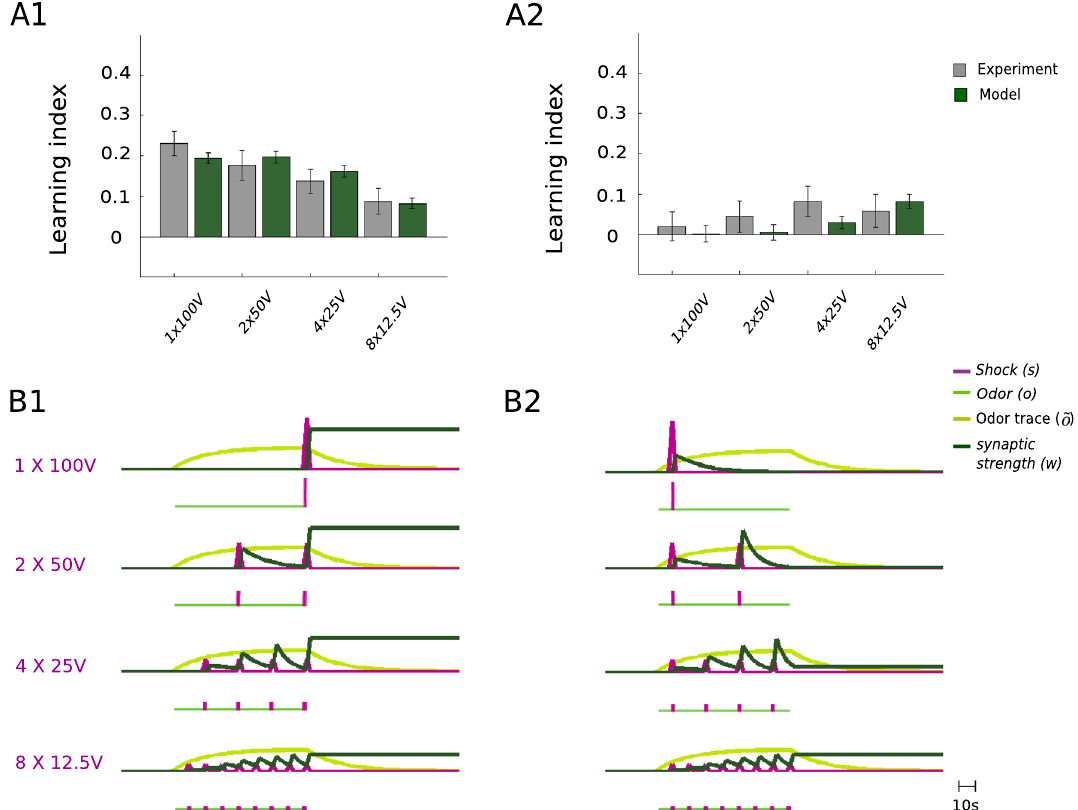
Figure 3. Predictive plasticity captures the sequence conditioning experiments. (A) In contrast to the purely associative learning (Eq. 6), the predictive plasticity (Eq. 7) fits well the shock-at-end data ( A1 ) and the shock-at-beginning data ( A2 , see Fig. 2). Error-bars represent SEM for both data and model. In the model, stochasticity enters through the Bernoulli process according to which each of the model flies chooses to avoid (with probability p cs ( v ) , Eq. (5)) or approach (with probability 1 − p cs ( v ) ) the odor. The same number of flies, N fly , and the same number of trials, N trial , was used in the model as in the experiment. (B) Traces for odor ( o ), shock ( s ), and synaptic strength ( w ) for the odor-to-shock prediction during conditioning, for the shock-at-end ( B1 ) and shock-at-beginning ( B2 ) protocols. Note that between the shocks, w decays towards 0 as the target for v = wo is s = 0 according to the predictive learning rule. The weight does not change if the prediction matches the shock representation, w o = s , e.g. when both are 0. The optimized parameters are: S ◦ = 6.90 V, α = 0.79 , τ o = 14.25 s, �η = 0.057 , τ η = 133.48 s, with mean square error MSE = 6.393 × 10 − 4 across all experiments (including the ones